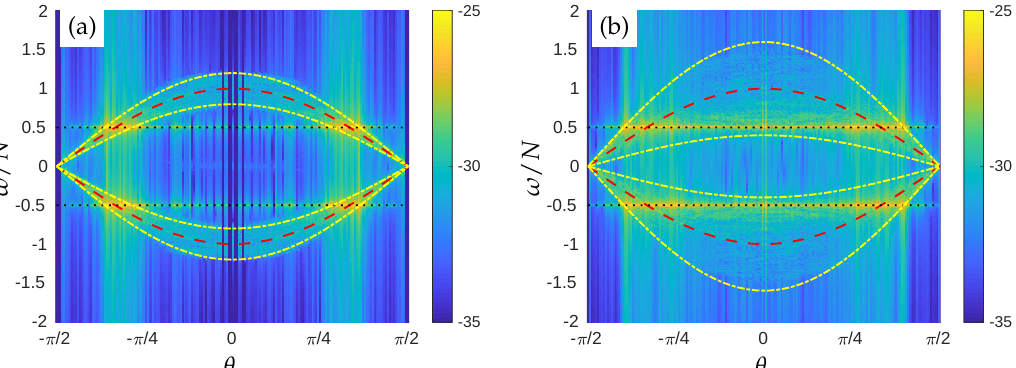
Figure 8. Effect of a VSHF background flow on the dispersion relation in function of the wavenumber amplitude k . The corresponding concentration of the energy density E is in the Fourier domain (in log scale) for: ( a ) small wave number range 16 < k ≤ 20; and ( b ) large wavenumber range 56 < k ≤ 60. The yellow dash-dotted lines correspond to the approximation of the sweeping effect with the maximum shear velocity done in Equation (15). The red dashed line is the original dispersion relation in Equation (2). The black dotted line is the forcing frequency ω f